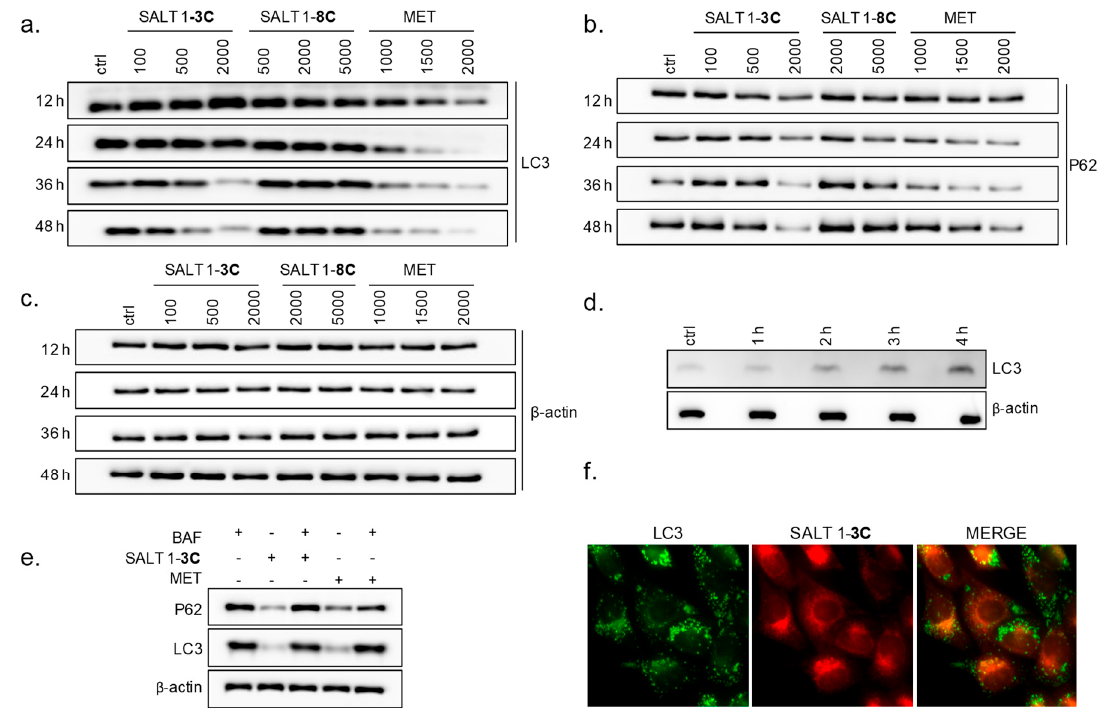
Figure 3. Mitochondrial fragmentation is accompanied by autophagy. Western blot of lysates prepared from A-375 cells treated with di ff erent concentrations of salt 1- 3C (100, 500, and 2000 nM) or salt 1- 8C (500, 2000, and 5000 nM) for di ff erent times (12, 24, 36, and 48 h). Metformin (MET) served as positive control (1000, 1500, and 2000 µ M for 24 h). Microtubule-associated protein light chain 3 (LC3), autophagy receptor sequestosome 1 (p62 / SQSTM1) (P62), and β -actin have apparent molecular weights on Western blots of 15, 60, and 42 kDa, respectively. ( a ) Detection of LC3. ( b ) Detection of P62. ( c ) Detection of β -actin as loading control. ( d ) Detection of LC3 and β -actin levels for A-375 cells treated with 100 nM bafilomycin 1A (BAF) for 1, 2, 3, and 4 h. ( e ) Detection of LC3, P62, and β -actin for A-375 cells treated with only BAF (100 nM for 4 h), only salt 1- 3C (2000 nM for 28 h), and only MET (2000 µ M for 28 h). In two variants, A-375 cells were pre-treated with 2000 nM MET or 2000 nM salt 1- 3C for 24 h and afterwards treated with 100 nM BAF for 4 h. ( f ) A-375 cells treated with 2000 nM salt 1- 3C (red) for 24 h and stained with anti-LC3 (green) (600 × magnification).